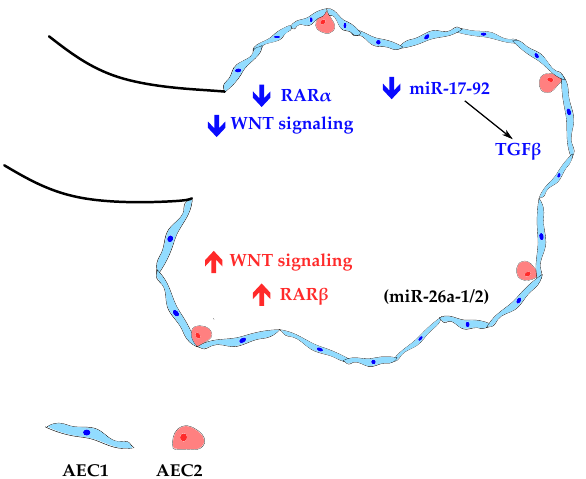
Figure 4. Simplified scheme of the signaling pathways involved in alveolar epithelial cell type 1 (AEC1) and type 2 (AEC2) differentiation during the saccular stage. Blue label: AEC1 differentiation; red label: AEC2 differentiation. (miR), present in the lung